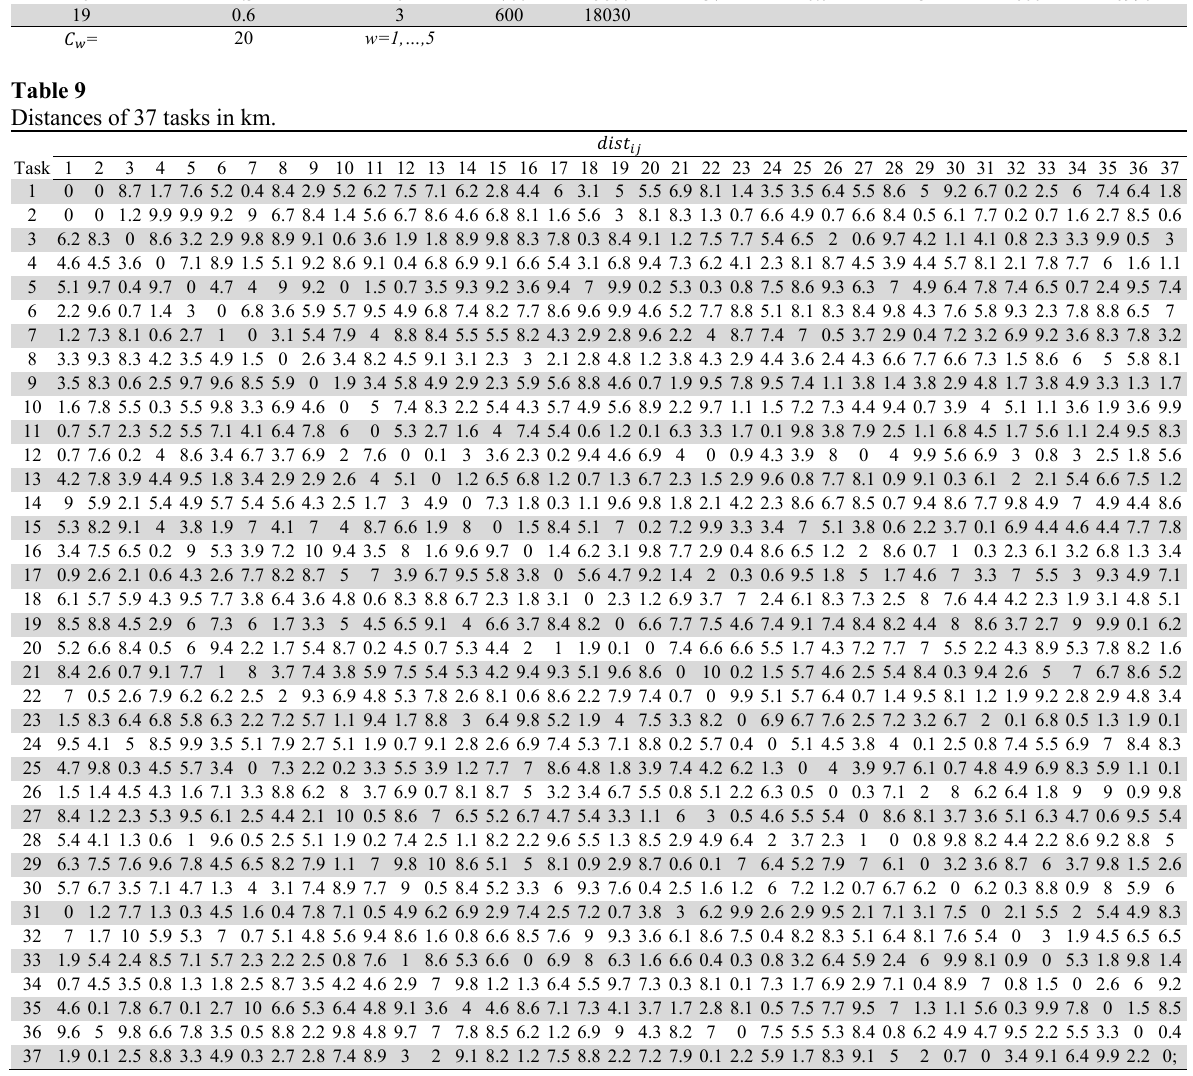
Distances of 37 tasks in